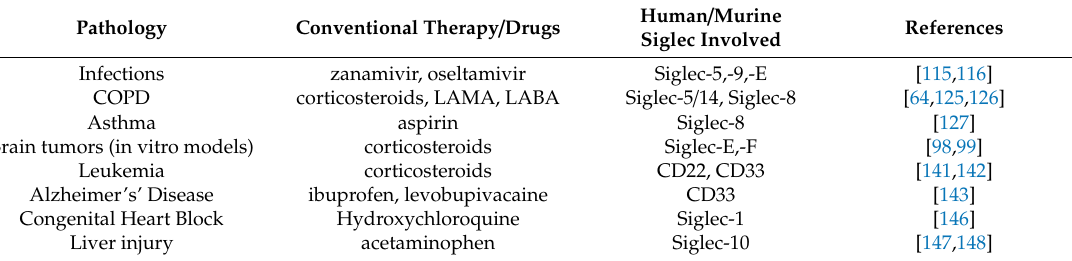
Table 1. Human / murine Siglec receptors in selective pathologies and related conventional